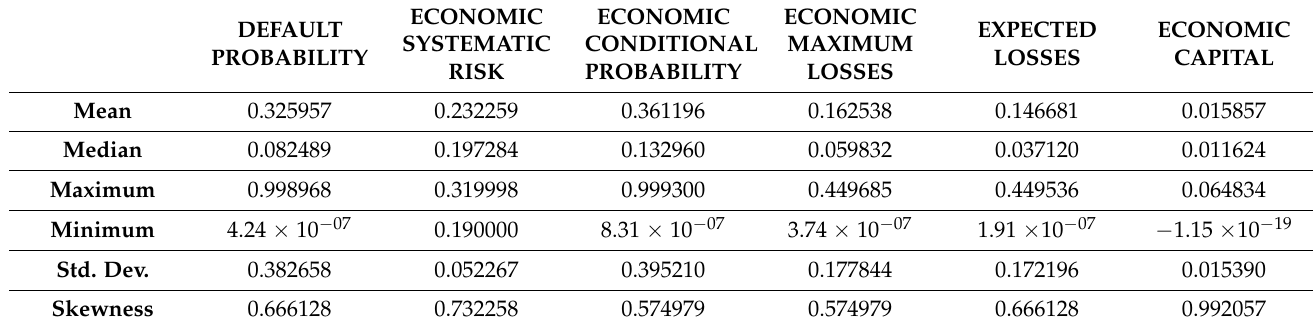
Table 3. Descriptive statistics: sensitivity to systematic risk and capital requirement according to the economic approach *.